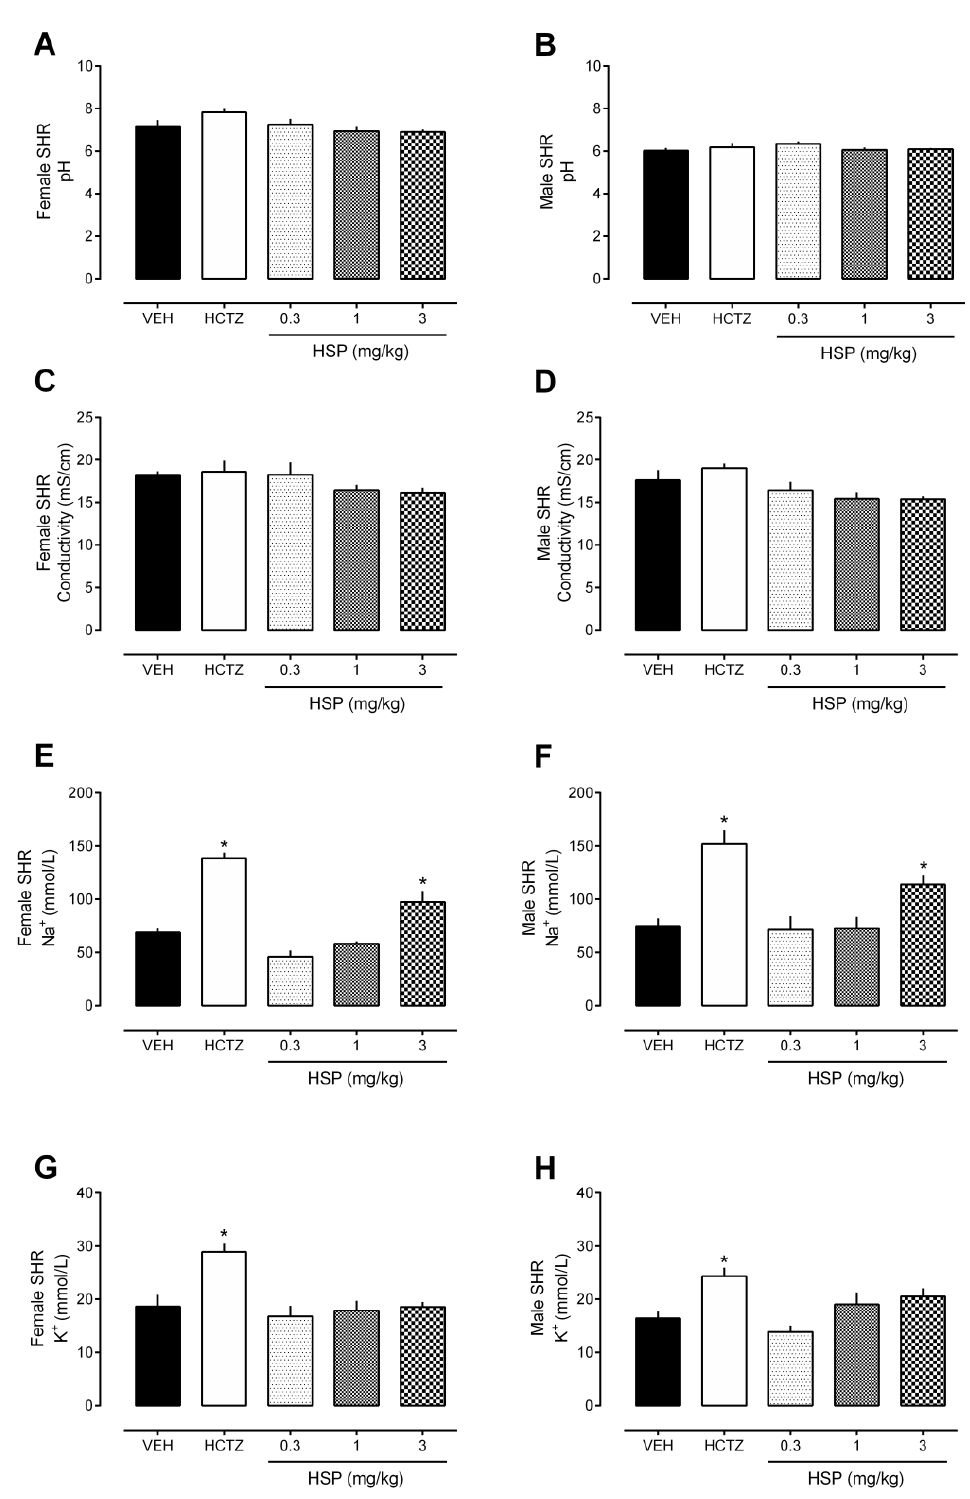
Figure 2. Urinary parameters (8 h) after oral treatment with hesperidin (HSP). ( A , B ) Urine pH values. ( C , D ) Urine conductivity values. ( E , F ) Urine Na + excretion. ( G , H ) Urine K + excretion. The values show the mean ± SEM. Statistical analysis was performed by means of one-way ANOVA followed by Dunnett’s multiple comparisons test. * p < 0.05 when compared with the VEH (vehicle; saline 10 mL/kg). HCTZ =